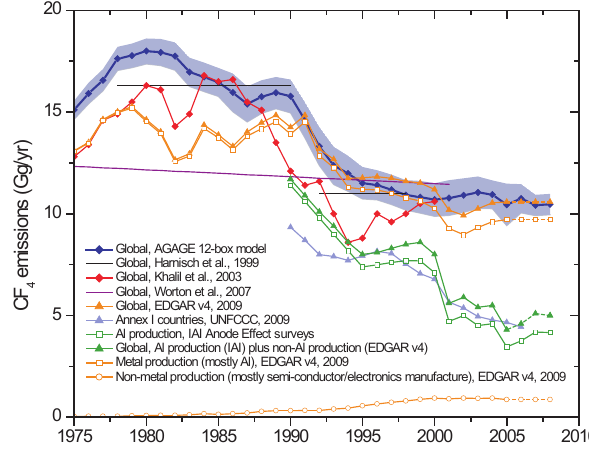
Fig. 4. Global CF 4 emissions from the inversion of AGAGE atmo- spheric data with the AGAGE 2-D 12-box model compared to the emissions reported by Harnisch et al. (1999), Khalil et al. (2003), Worton et al. (2007), the EDGAR v4 (2009) emission database, and Annex I countries (UNFCCC, 2009, Table S1). Also shown are estimates of CF 4 emissions from Al production (IAI Anode Effect surveys), a global CF 4 emission estimate as the sum of these Al pro- duction CF 4 emissions and non-metal production related CF 4 emis- sions (EDGAR v4, mostly semiconductor/electronics manufacture), and the EDGAR v4 estimates for CF 4 emissions from metal pro- duction (mostly Al) and non-metal production. 2005 EDGAR v4 estimates have been used for 2005–2008 (shown as dashed